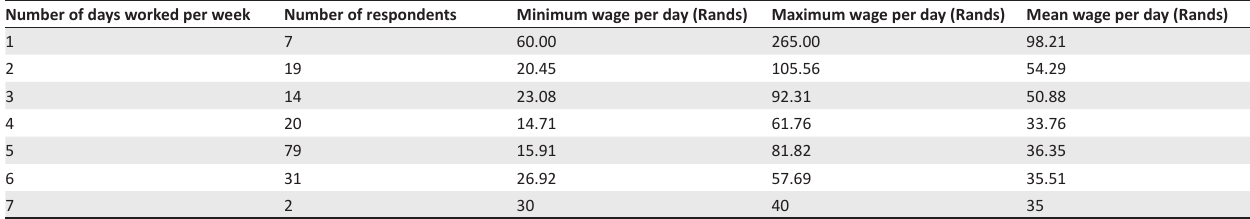
TABLE 6: Domestic workers’ average wage per day in Soshanguve and Orchards in 2007. Number of days worked per week